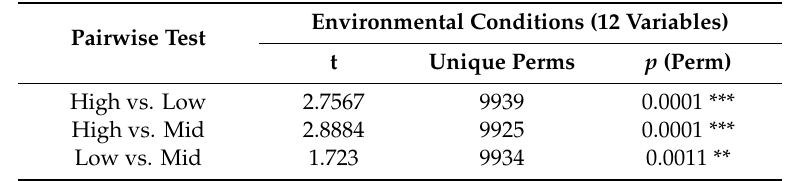
Table 1. PERMANOVA post hoc tests for environmental conditions between the di ff erent tidal zones in R ó balo Bay, Navarino, Chile. Asterisks indicate significant di ff erences (** p < 0.01, *** p < 0.001).